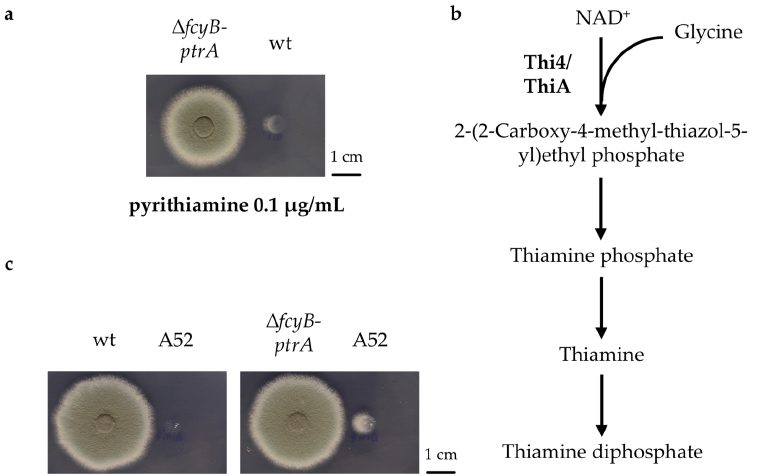
Figure 1. Proximity effect of A. fumigatus strain carrying the ptrA cassette. ( a ) Spot assay on solid AMM containing 0.1 µ g/mL pyrithiamine showing partial growth of the wt strain in proximity to ∆ fcyB-ptrA . ( b ) Simplified version of the thiamine biosynthetic pathway, adapted from Dietl et al. [28]. ( c ) Spot assay on solid AMM using A52 as reporter strain spotted in proximity to either wt or ∆ fcyB-ptrA .